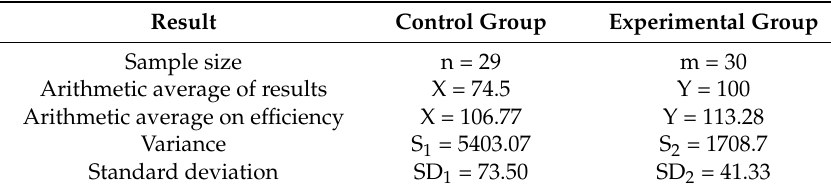
Table 5. Results for Activity 1 using the PrimBox